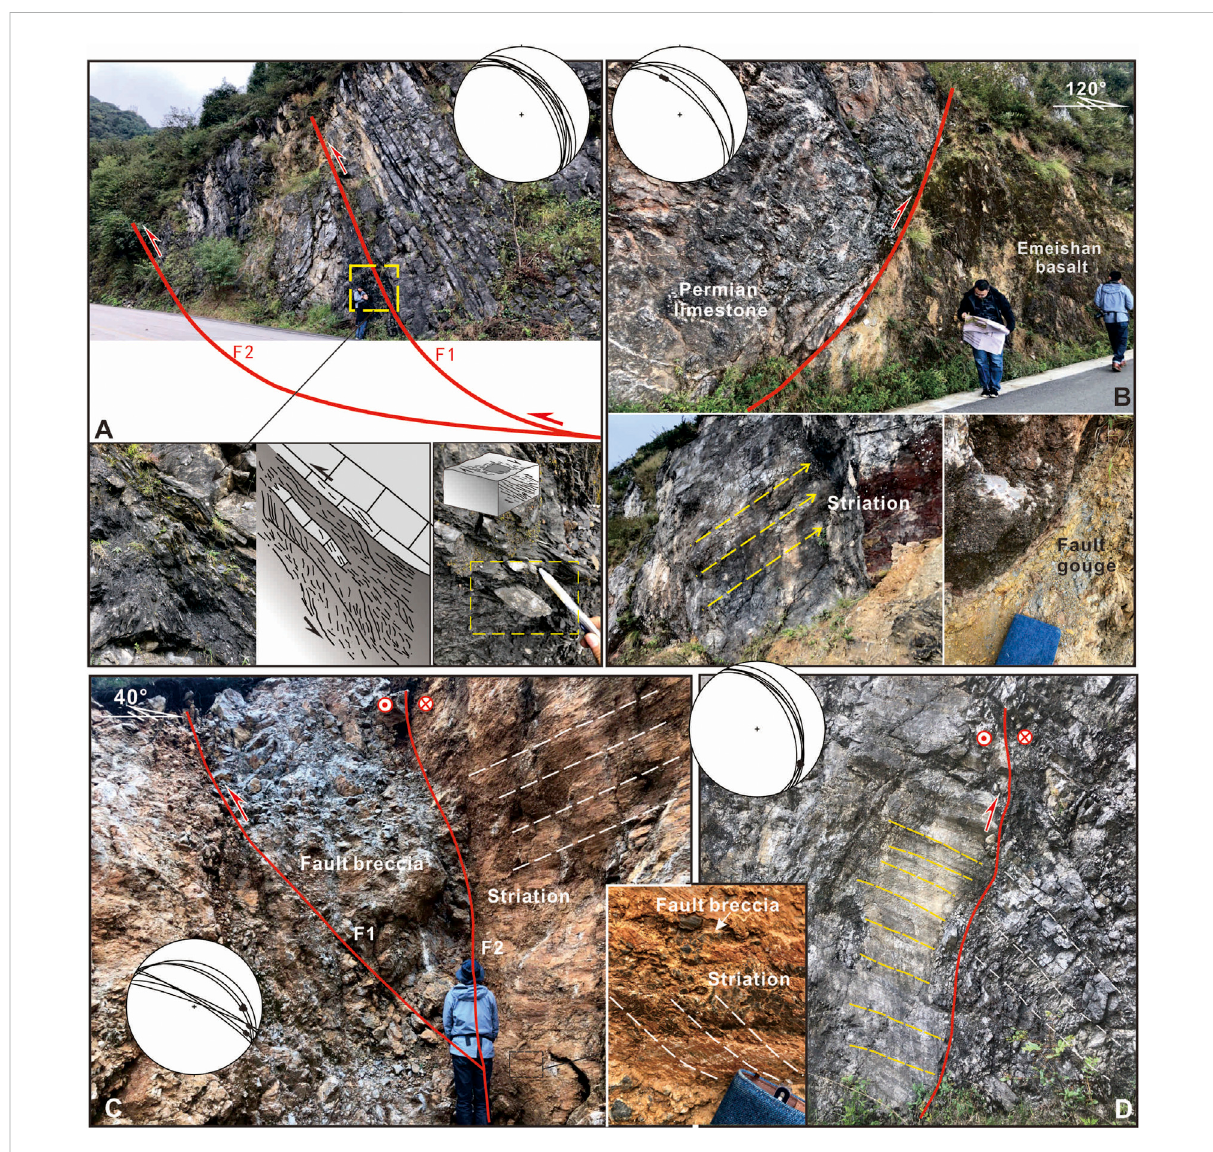
Typical deformation associated with dextral thrusting and sinistral transpression. (A) A series of thrust faults developed in the Carboniferous limestone. Deformation fabrics indicate a top-to-the-SW sense of thrusting with a component of dextral strike-slip motion. (B) The